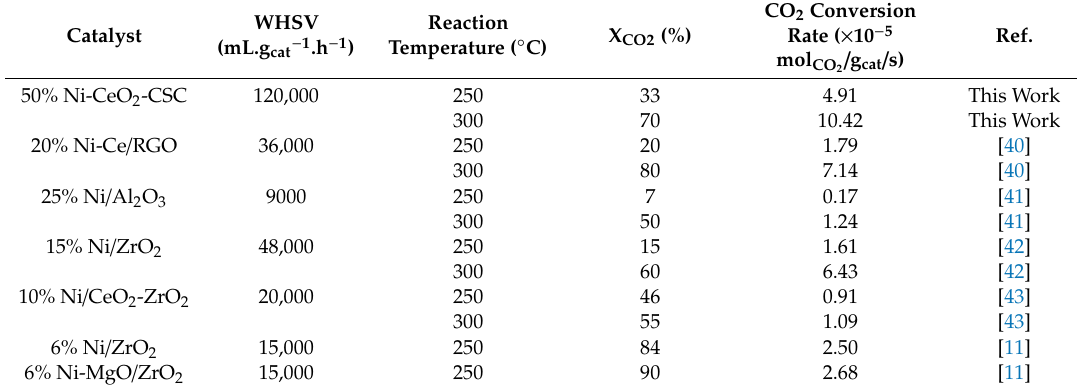
Table 3. CO 2 conversion rate and CH 4 selectivity of the 50% Ni-CeO 2 -CSC catalyst and recently reported low-temperature CO 2 methanation catalysts in the literature at 0.1 MPa.